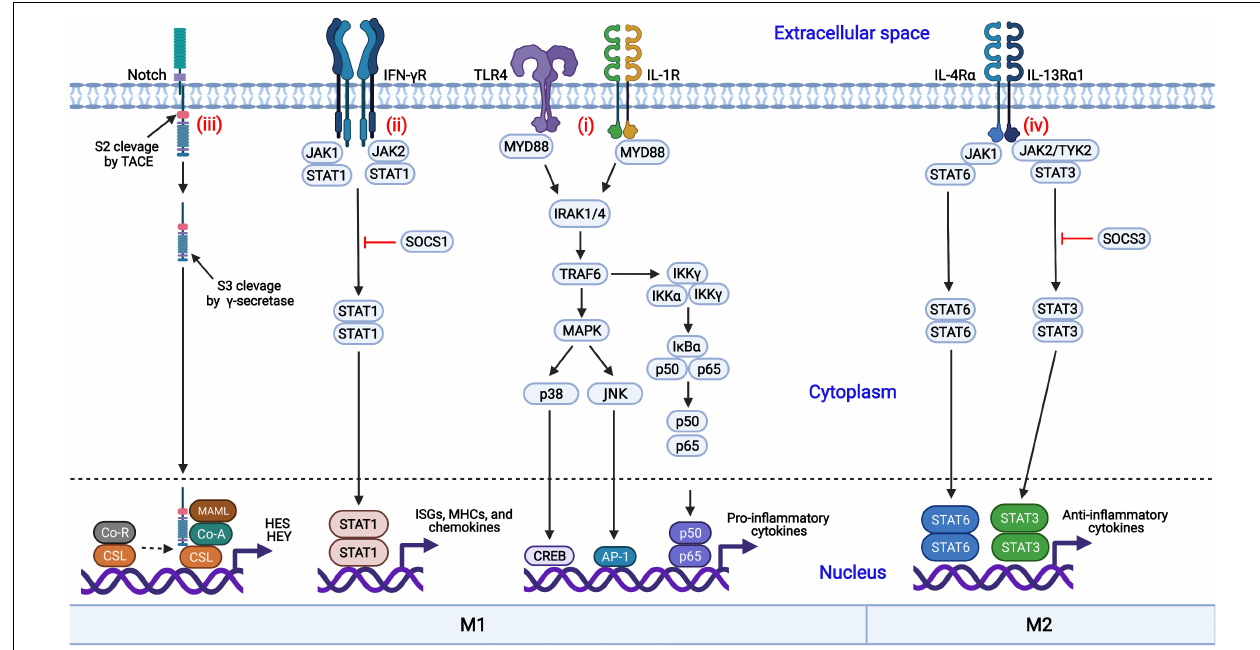
FIGURE 1 | Coordinated regulation of macrophage polarization via multiple signaling pathways. (i) Engagement of TLR4 or IL-1R with the ligands results in the activation of the MAPK and NF- κ B signaling pathways and induces the nuclear translocation of several transcription factors, promoting the production of proinflammatory cytokines; (ii) IFN- γ binds to its receptor, IFN- γ R, and triggers the phosphorylation and dimerization of STAT1, initiating the transcription of IFN-stimulated genes (ISGs); (iii) The interactions of Notch proteins with Delta-like ligands and Jagged ligands induce the activation and nuclear translocation of the Notch intracellular domain (NICD), driving the production of proinflammatory cytokines; (iv) IL-4 or IL-13 binds to its corresponding receptor and triggers the activation of STAT3 or STAT6, respectively, inducing the transcription of anti-inflammatory cytokines and skewing macrophages to the anti-inflammatory M2